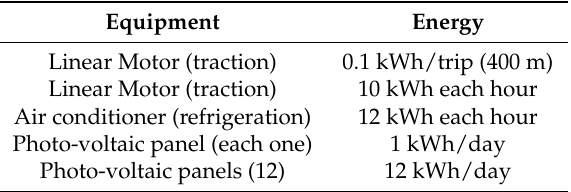
Table 5. MagLev 2 -Cobra: Energy